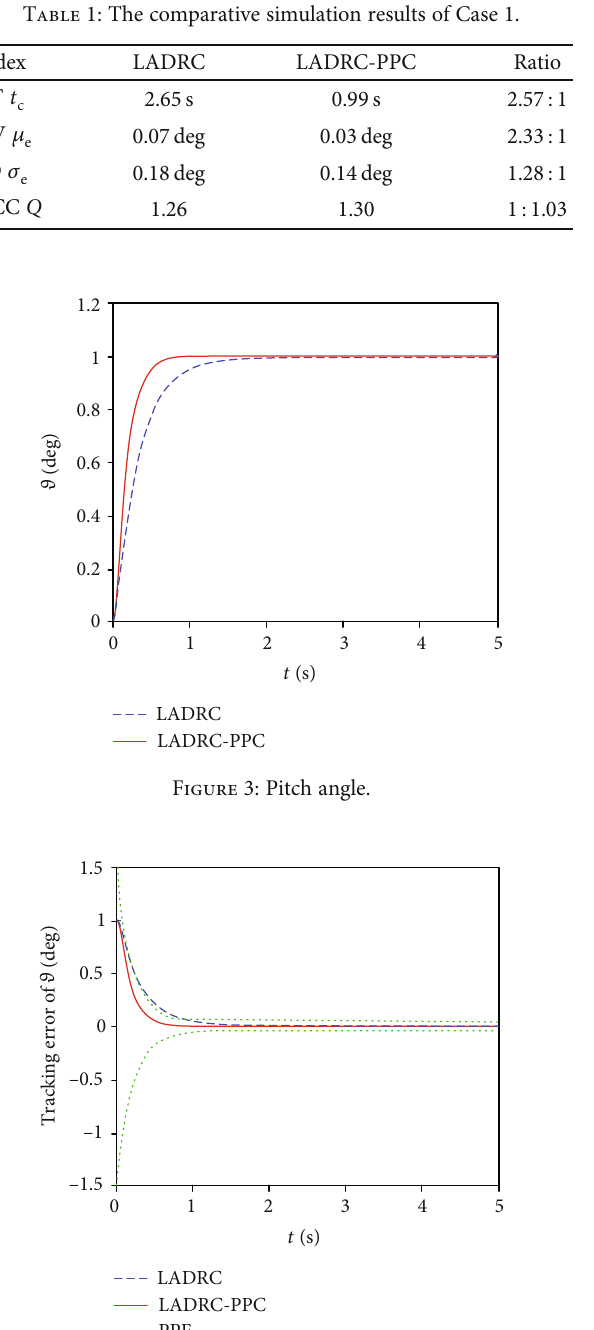
Figure 4: Tracking error of pitch angle.